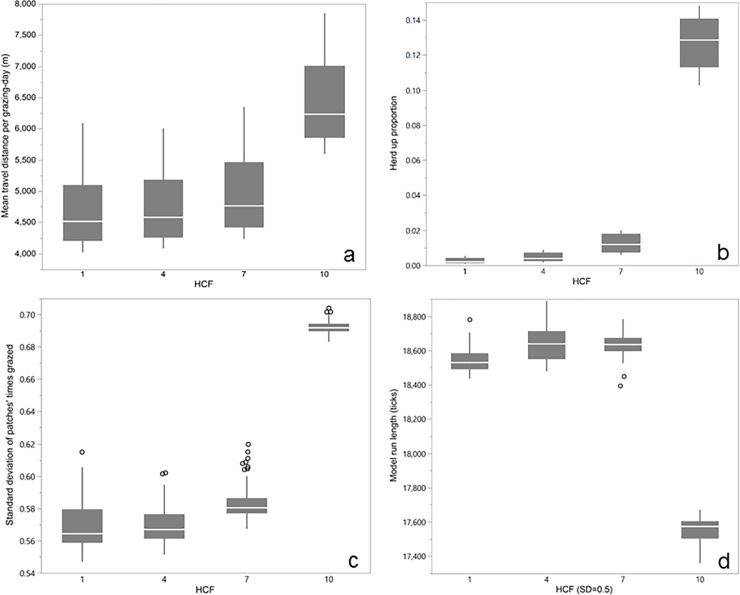
Box plots of various model evaluation data demonstrating effect of distinct persistent subherds.(a) Mean individual travel distance per grazing day (m) by herd cohesion factor (HCF); (b) Proportion of use of assess herd procedure (versus environmental movement) to choose a new grazing patch, a measure of herd-based versus individual optimization, by HCF; (c) Standard deviation of times-grazed count for all patches at end of model run, a measure of grazing heterogeneity, by HCF; (d) Total model run length, an inverse indicator of grazing efficiency, by HCF at stocking density = 0.5.